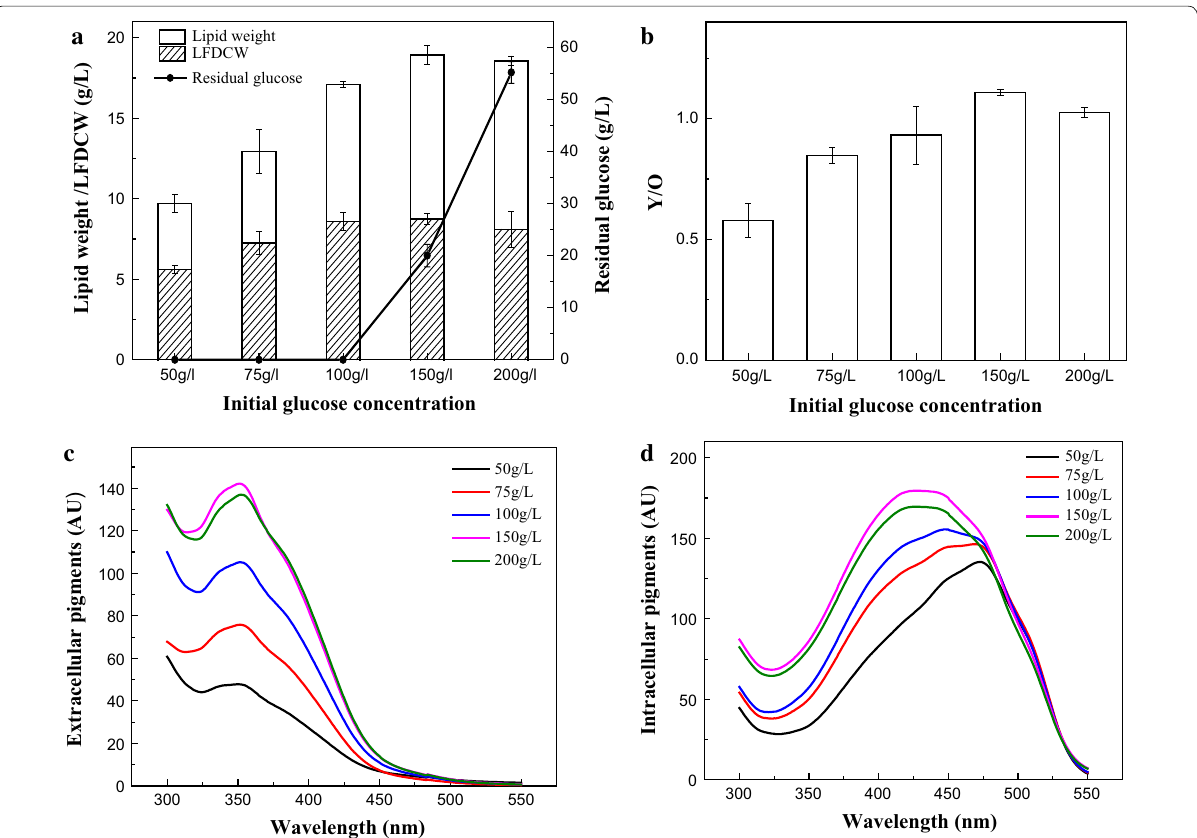
Fig. 1 Metabolism of lipid and pigments with IGC of 50, 75, 100, 150 and 200 g/L. a Lipid weight (g/L), LFDCW (g/L) and residual glucose (g/L). b Ratio of intracellular yellow to orange pigments (Y/O). c Spectra of extracellular pigments. d Spectra of intracellular